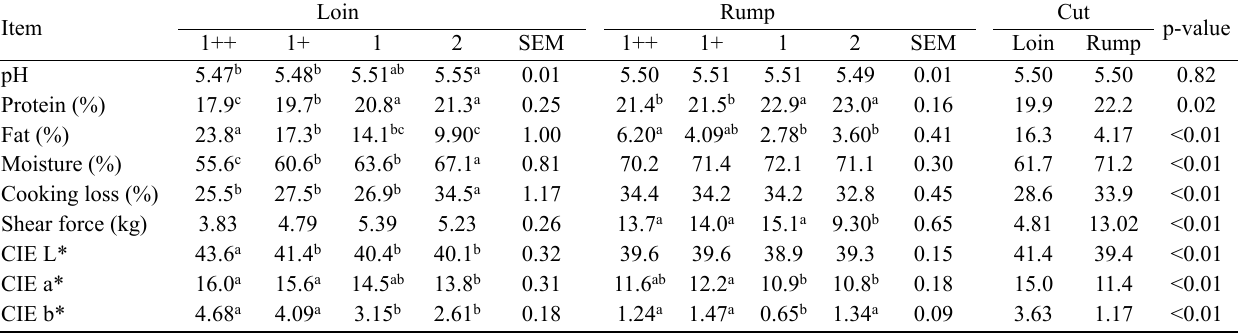
Table 4. pH, chemical composition, cooking loss, meat color (CIE L*, a*, and b*), and Warner-Bratzler shear force of loin and rump with different quality grades in Korean cattle steers